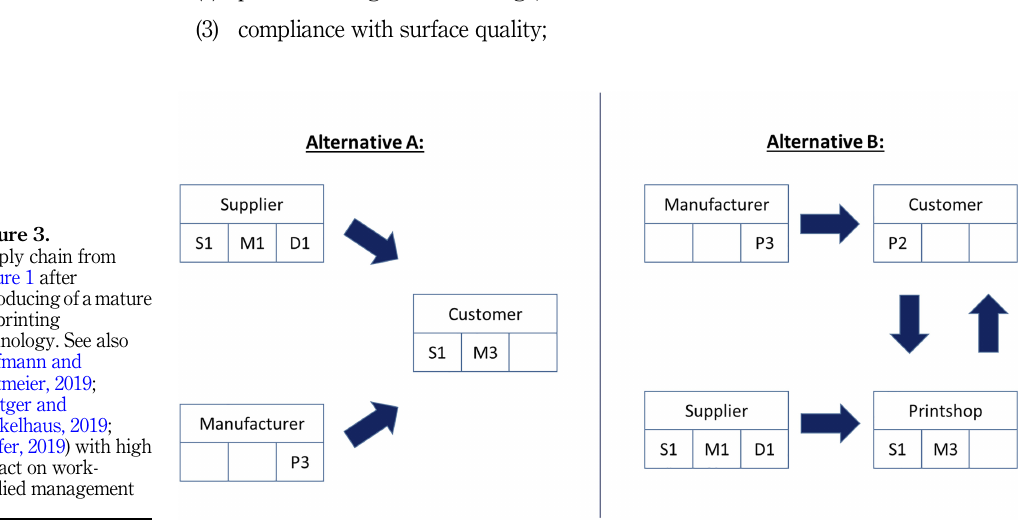
Figure 3. Supply chain from Figure 1 after